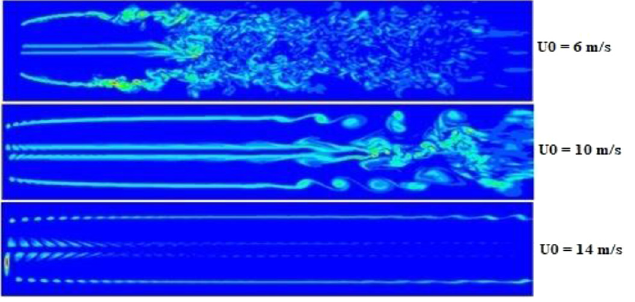
Fig. 1. Wake evolution downstream a WT ’ s hub (adapted from [9]).